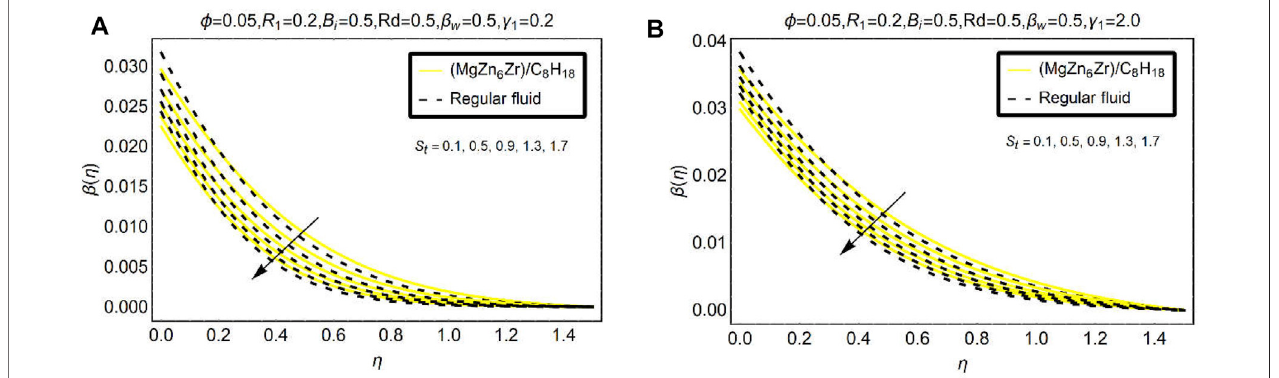
FIGURE 12 | Temperature via S t (A) γ 1 (cid:2) 0 . 2 and (B) γ 1 (cid:2) 2 . 0.